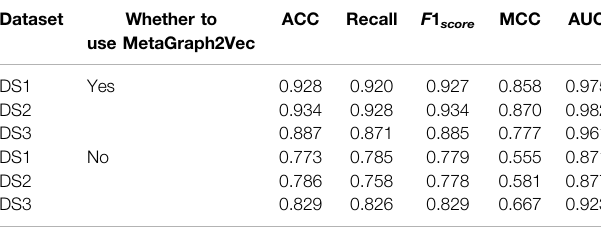
TABLE 4 | Performance comparison of representation learning without MetaGraph2vec.